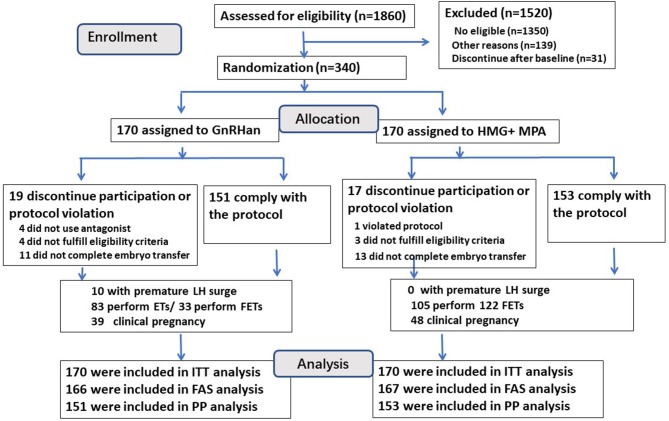
The flow chart of this trial.